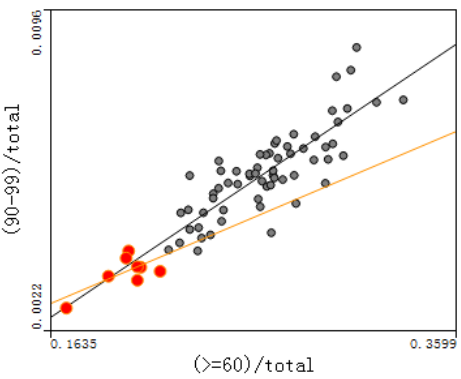
Figure 8. Relationship between the 90–99 ratio and the degree of aging.